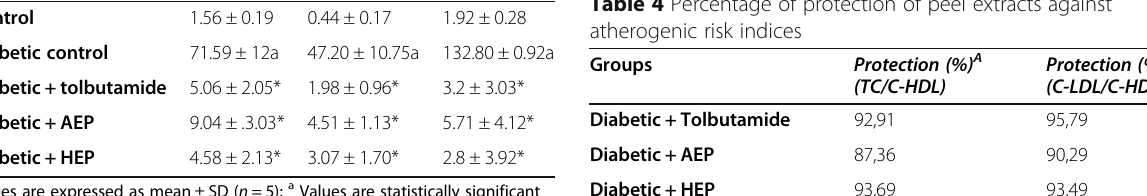
Table 4 Percentage of protection of peel extracts